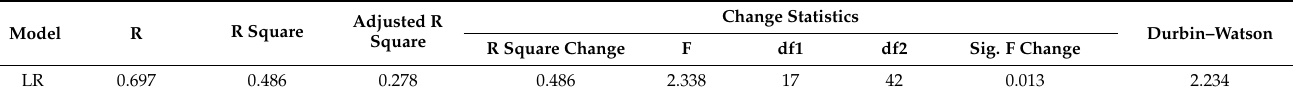
Table 2. The results of the LR